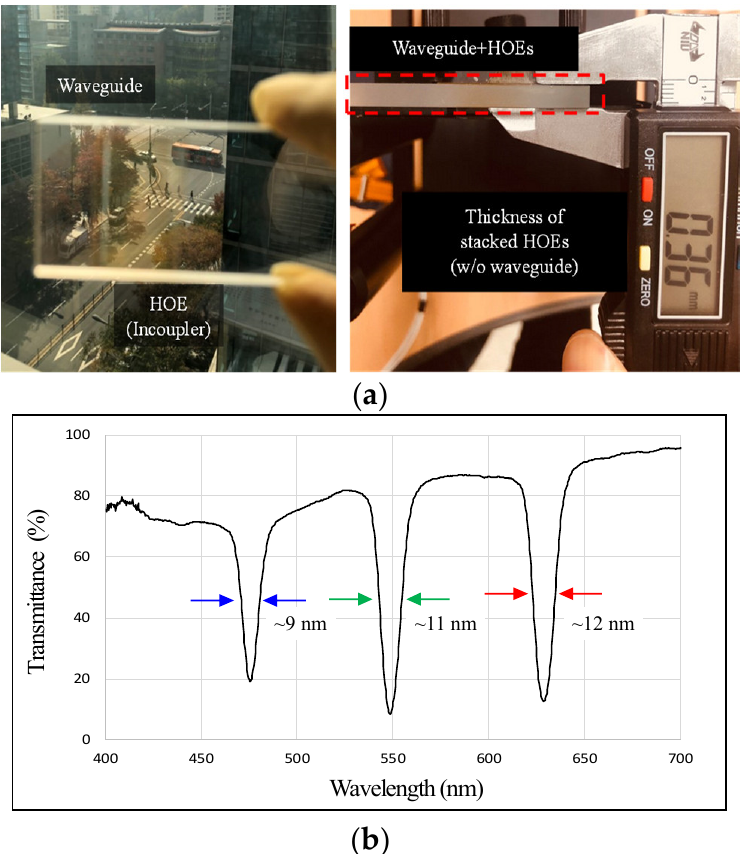
Figure 6. Experimental setup for recording HOEs: ( a ) the schematic, and ( b ) the picture of optical setup for recording the HOE couplers on the holographic waveguide.